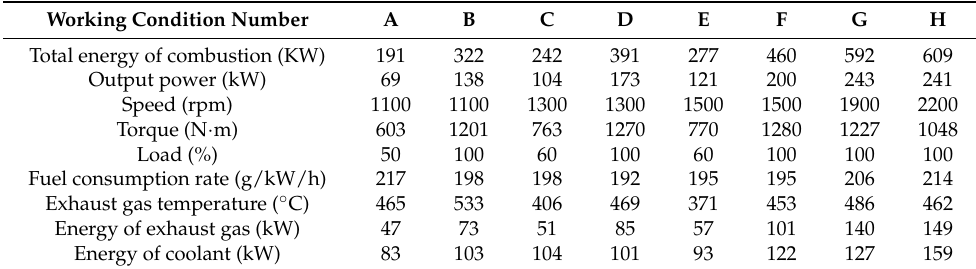
Table 5. Performance of diesel engine under various working